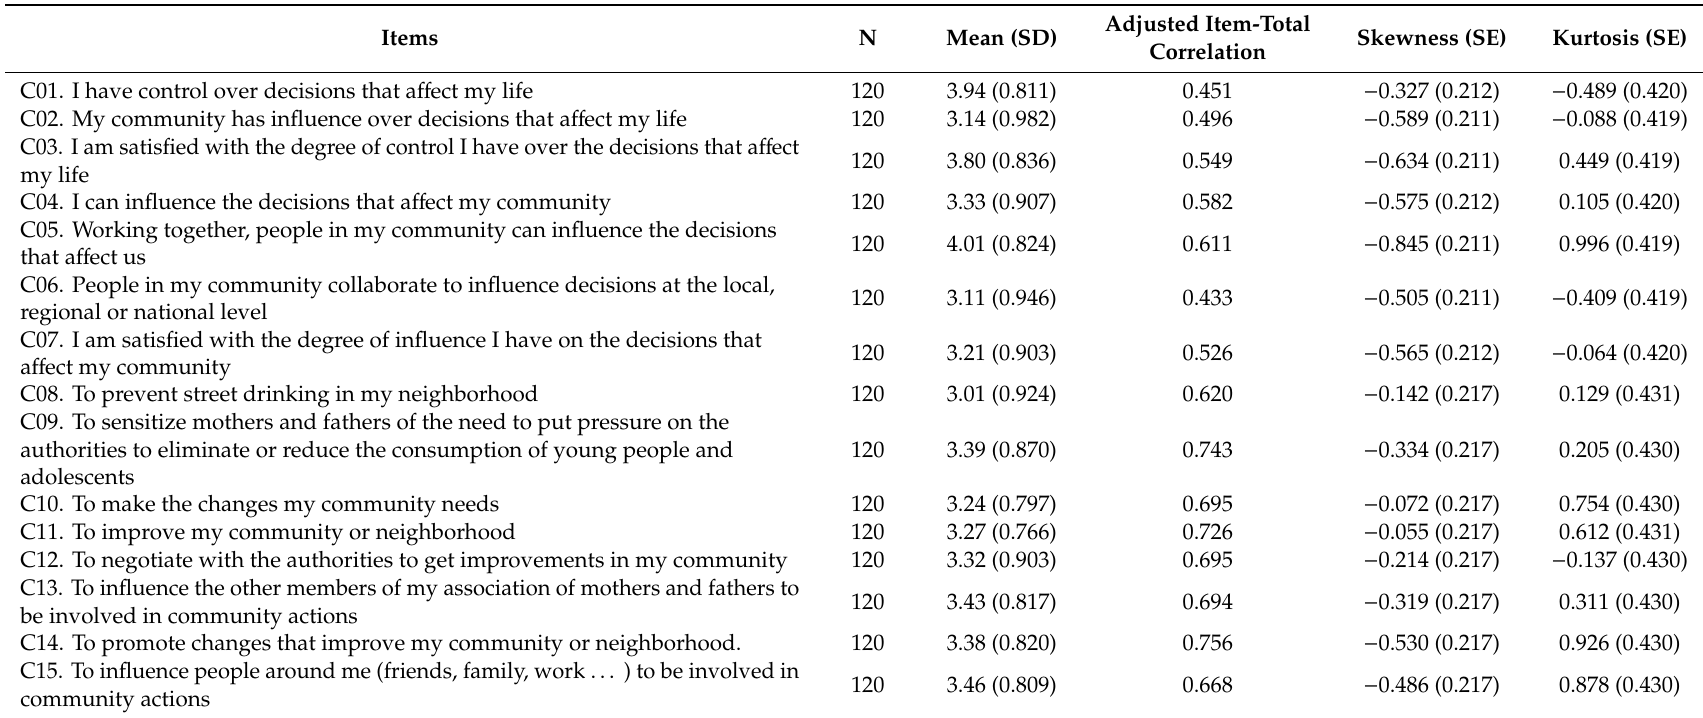
Table 1. Means, standard deviations, adjusted item-total correlation, skewness, and kurtosis for all items (range: 1–5).